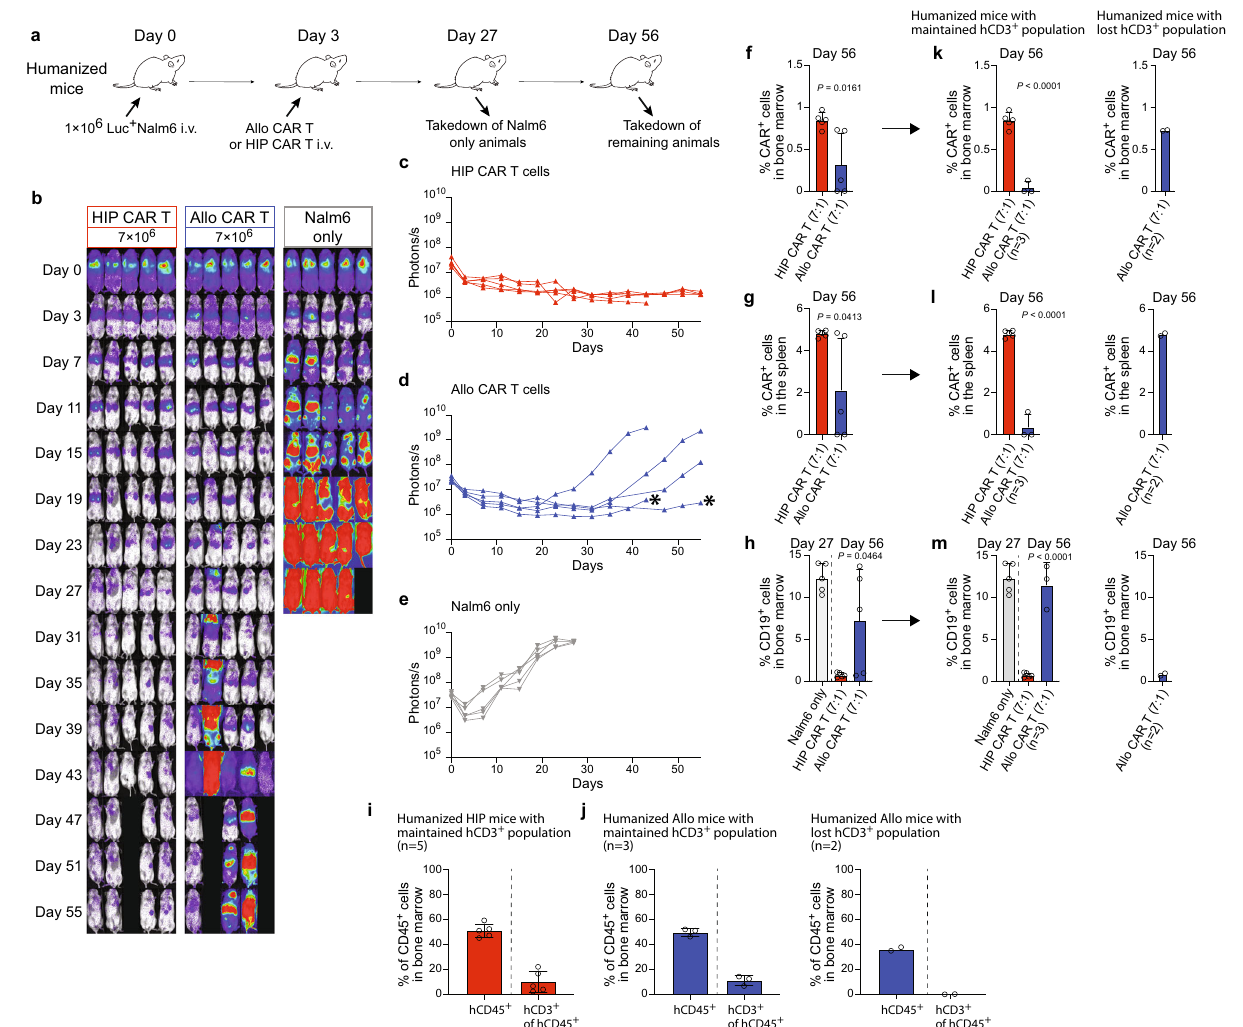
Fig. 7 | HIP CAR T cells provide lasting tumor control in fully immunocompe- tent allogeneic humanized mice. a Humanized mice were injected with 1×10 6 Luc + Nalm6 cells and received 7×10 6 allo CAR T cells or HIP CAR T cells on day 3 (one experiment). Spleen and bone marrow were taken after 27 or 56 days. b BLI images show the tumor burden for all mice in this study. c – e Graphs show BLI signals for animals in the HIP CAR T ( c ) and allo CAR T cell groups ( d ), and the Nalm6 only group ( e , all single animals are shown). * indicates outliers that got assessed further. f , g The percentages of CAR + cells in the bone marrow ( f ) and spleen( g )wereassessedonday56(mean±SD, n =5animalspergroup).Signi fi cant differences between the two CAR T cell groups are shown. h The percentage of CD19 + cells in the bone marrow was assessed on day 56 as endpoint (mean±SD, n =5 animals per group) and were signi fi cantly different. Endpoint values from earlier euthanized mice in the allo CAR T group due to high tumor burden were included in the day 56 graphs. i , j Reconstitution of human immune cells was